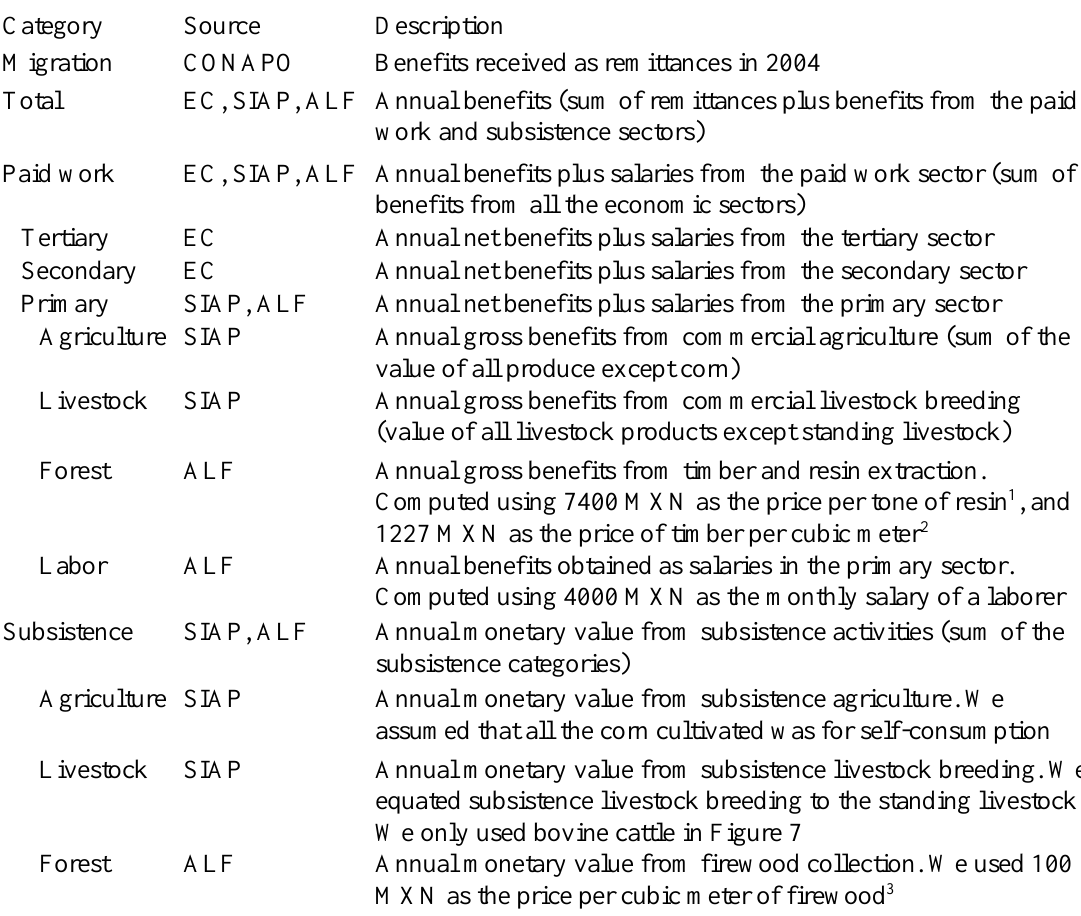
Table A1.3. Variables used for characterizing benefits in relational